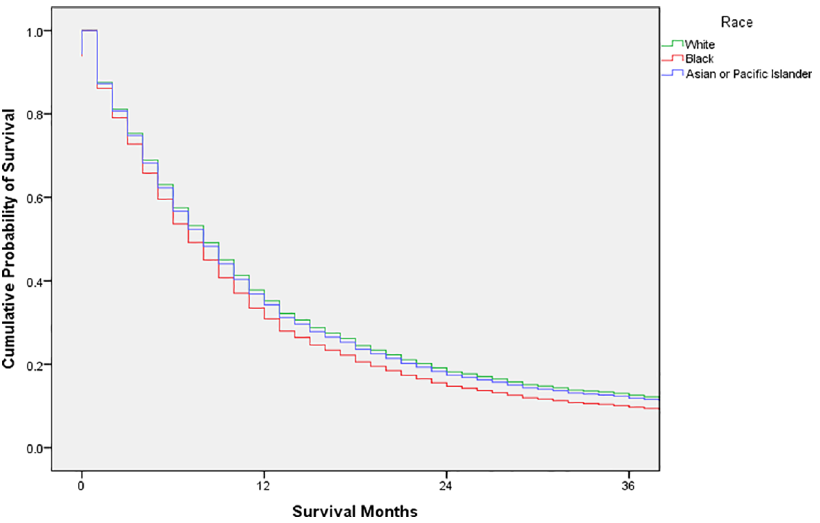
Fig 3. Adjusted survival curves, by race, for adult patients in the SEER database diagnosed with esophageal squamous cell carcinoma, 1980–1989.